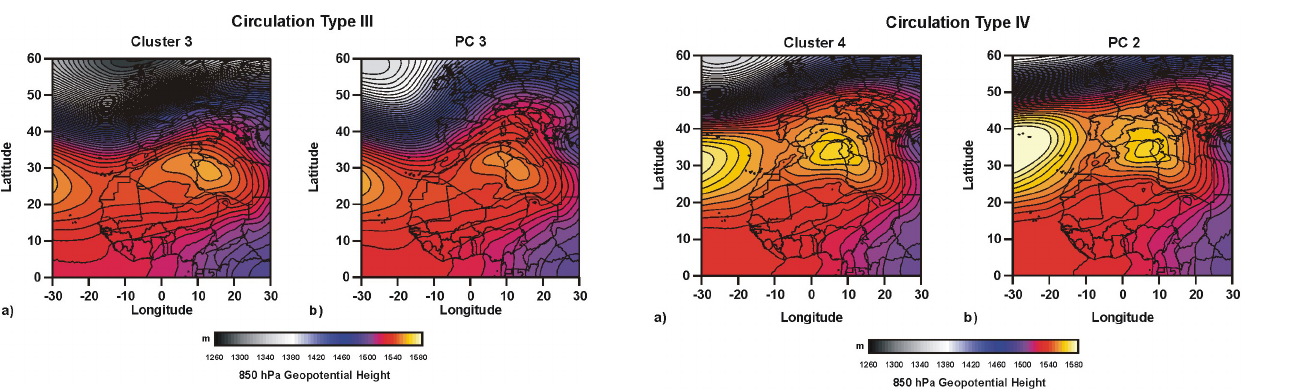
Figure 5. Composite 850hPa geopotential height (m) representing circulation type IV leading to ADO over the western Mediterranean